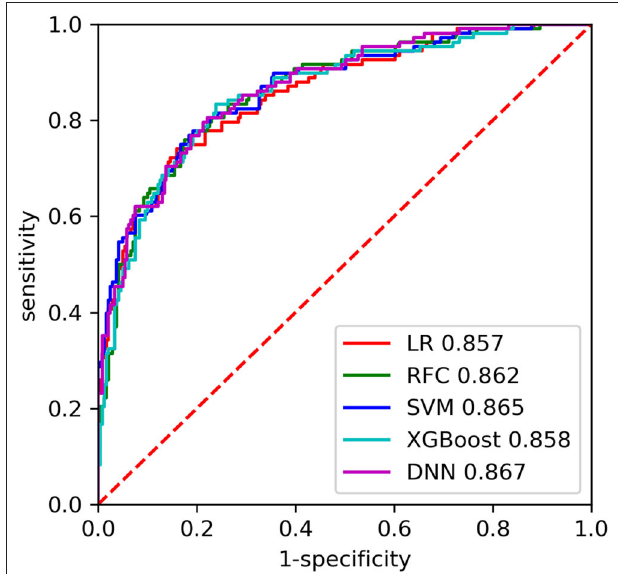
FIGURE 2 | The receiver operating characteristic (ROC) curves of the machine learning (ML) models on the testing set. LR, logistic regression; SVC, support